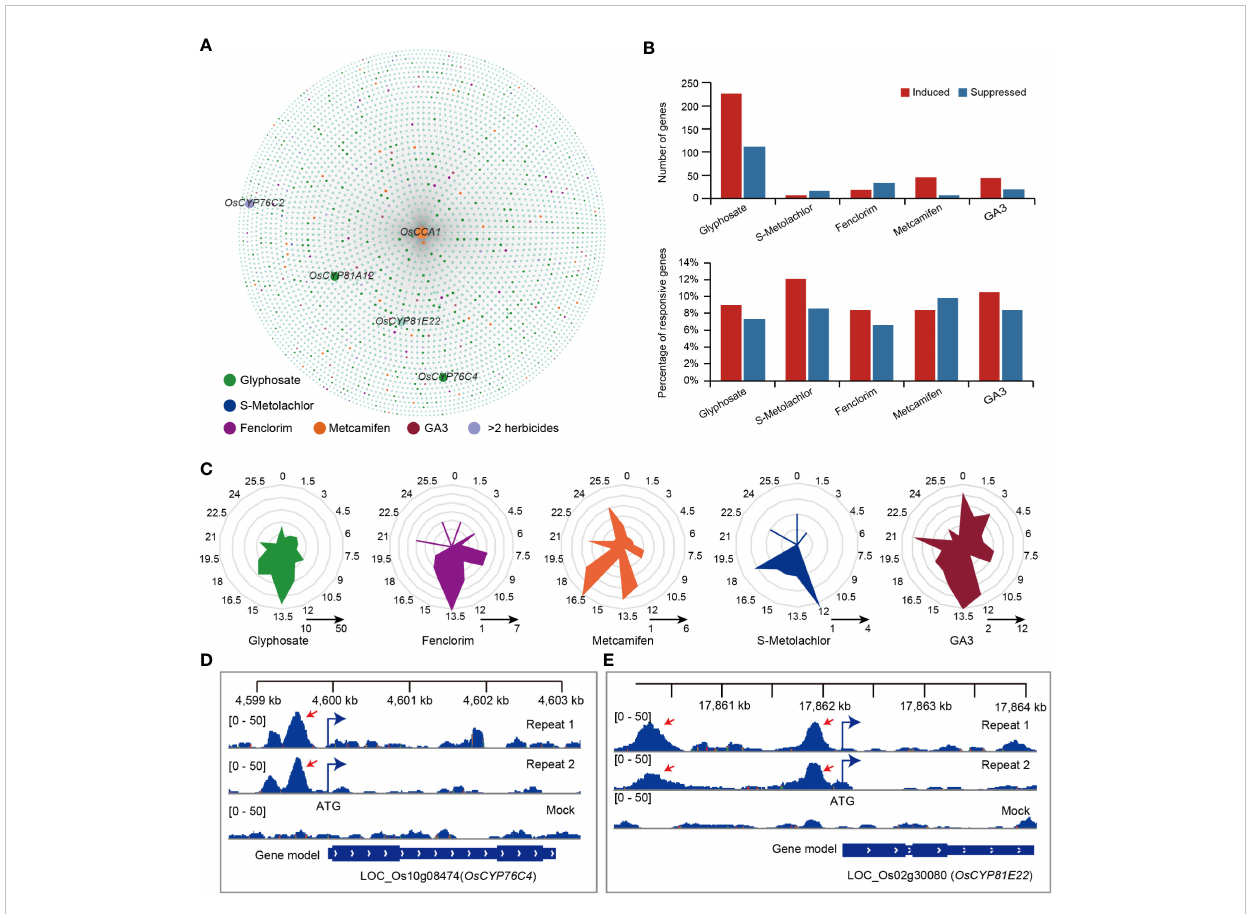
FIGURE 5 The crosstalk of OsCCA1 target genes and herbicide-responsive genes. (A) OsCCA1 and its target genes ( OsCCA1 has a binding peak within 1000 bp upstream of the start codon of this gene.) association network, the closer to OsCCA1 gene indicates that the DAP-seq peak is closer to the promoter of the gene. (B) The statistics of genes induced or suppressed by herbicide in OsCCA1 target genes. upper: the number of herbicide- responsive genes in OsCCA1 target gene sets. bottom: the proportion of OsCCA1 targeted herbicide-responsive genes in total herbicide-responsive genes. (C) Phase distribution of herbicide-responsive OsCCA1 target genes. (D) The binding peaks (repeats 1 and 2) and negative control (mock) of OsCCA1 in the promoter ( – 549 bp) of OsCYP76C4 by DAP-seq. The [0 – 50] shows the scale bar of binding peak that refers to the height of the peak. (E) The binding peaks (repeats 1 and 2) and negative control (mock) of OsCCA1 in the promoter ( – 276 bp) of OsCYP81E22 by DAP-seq. The [0 – 50] shows the scale bar of binding peak that refers to the height of the